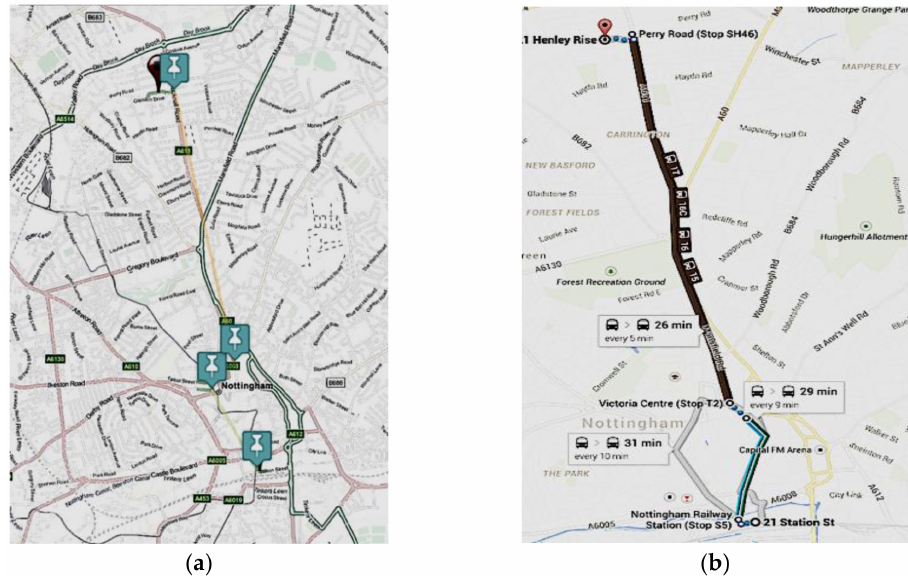
Figure 14. A comparative public transport route calculation (in Nottingham): ( a ) EMRG result; ( b ) Google Maps result.